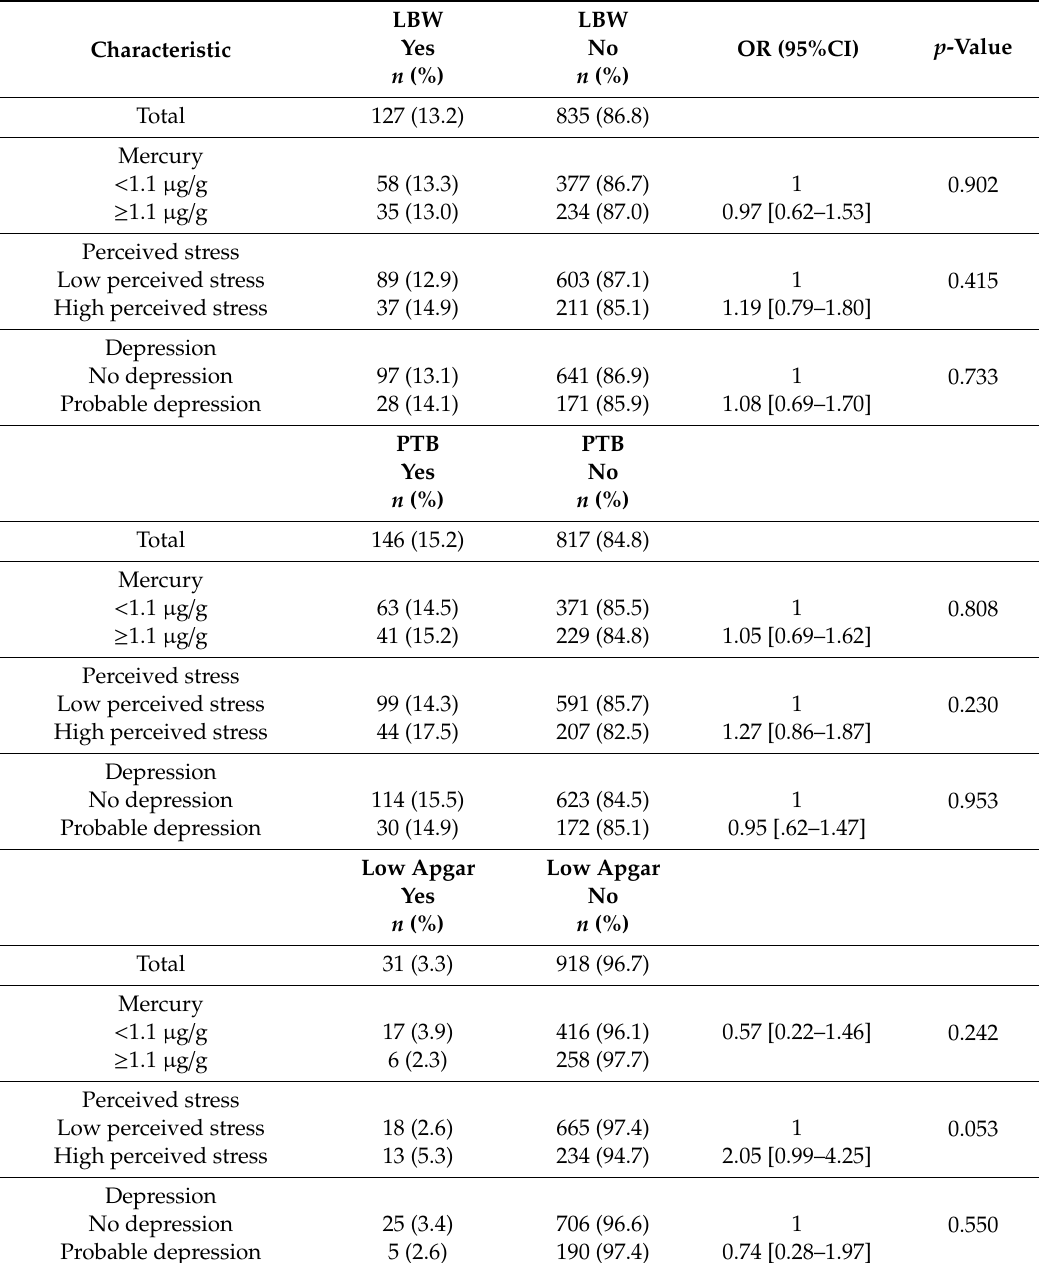
Table 3. Association between mercury, perceived stress, and depression, and adverse birth outcomes.